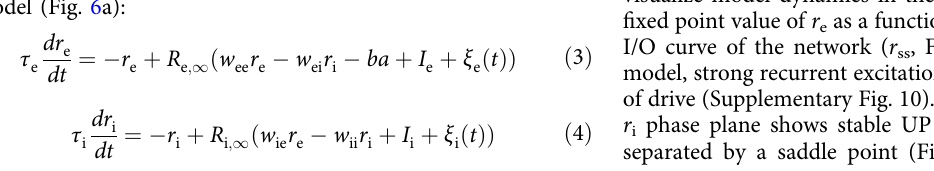
plane. The dotted line separates the basin of attraction for the DOWN and UP state fi xed